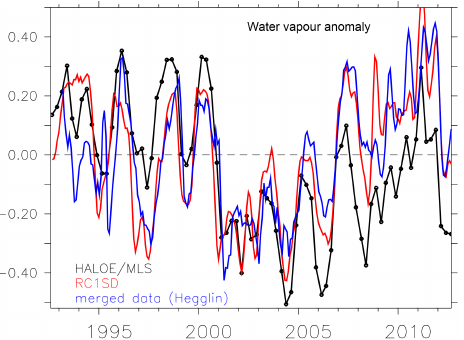
Figure 2. Cold point temperature anomalies in the tropics (20 ◦ S– 20 ◦ N) derived from radiosonde data (black line). The data were al- ready published by Randel and Jensen (2013) in their Fig. 5a (lower graph). The red line is the RC1SD simulation (deseasonalized, 3- month running mean). The correlation coefficient is r = 0 .